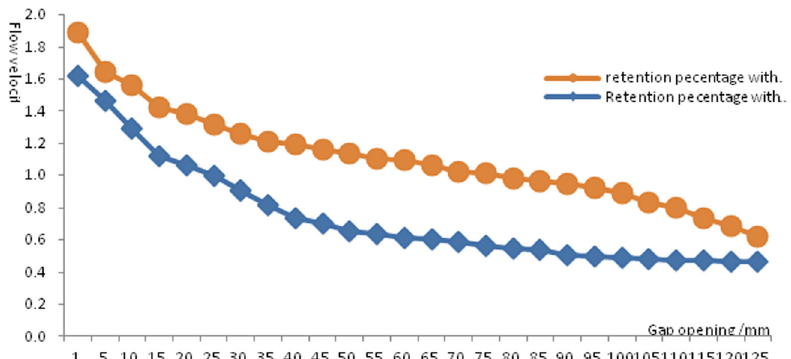
Figure 14: Leakage - blocking effect of different slurries and different strata.